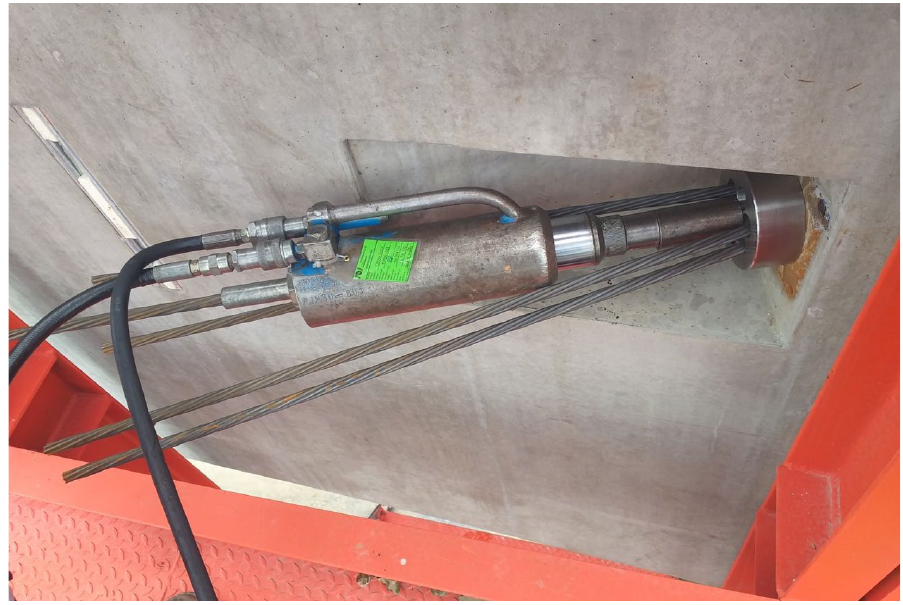
Figure 3. Anchorage for T6.